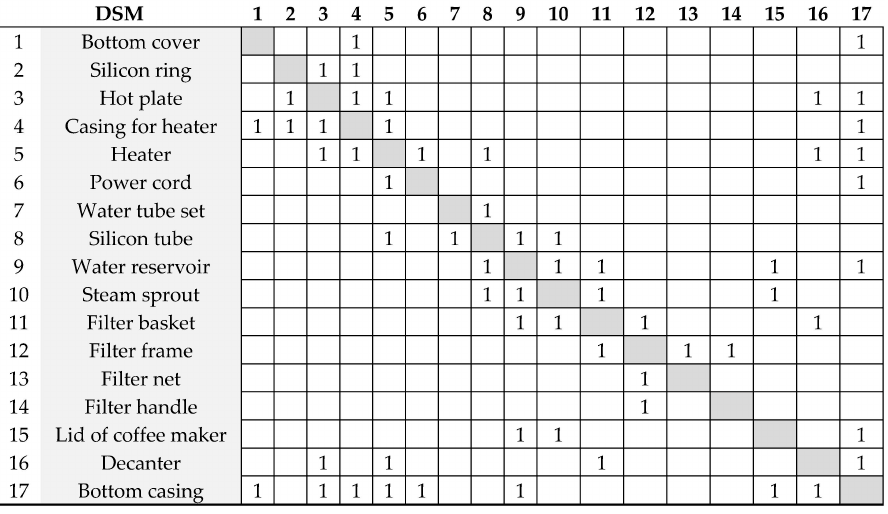
Table 3. Design structure matrix of the co ff ee maker.